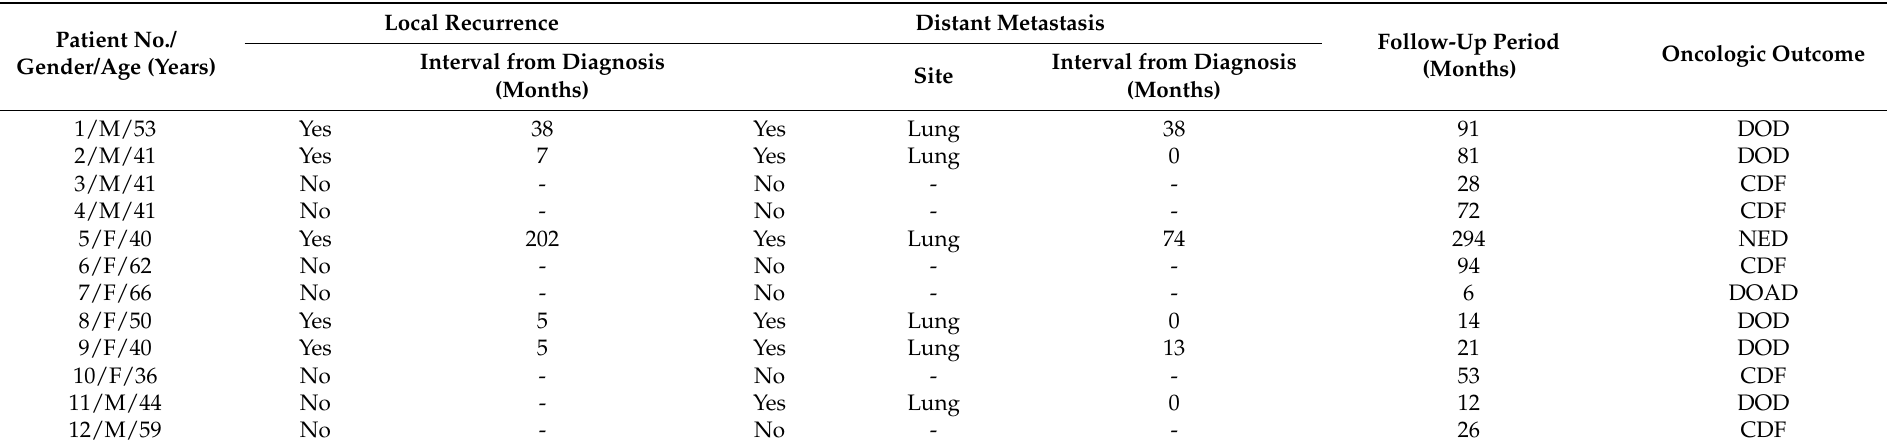
Table 2. Prognosis after malignant transformation of giant cell